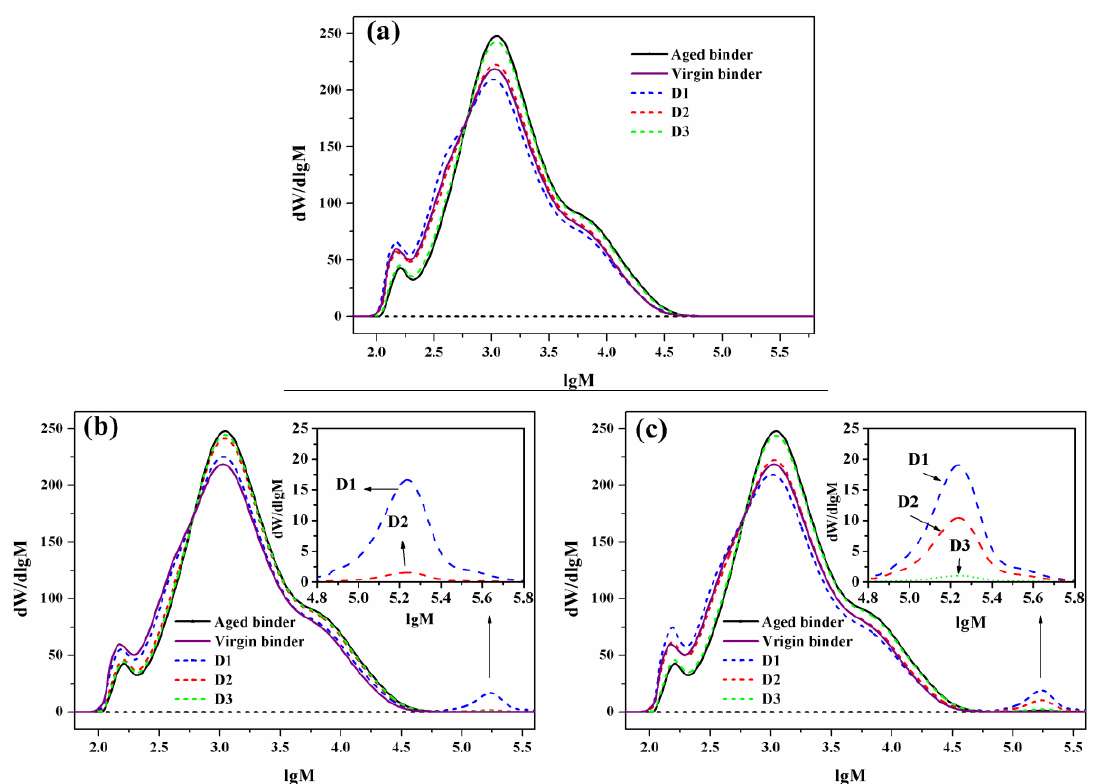
Figure 4. The molecular weight distribution curves for asphalt binder samples: ( a ) virgin binder, aged binder, CR rejuvenated binder in D1, D2 and D3 slices; ( b ) virgin binder, aged binder, MR-1 rejuvenated binder in D1, D2 and D3 slices; ( c ) virgin binder, aged binder, MR-2 rejuvenated binder in D1, D2 and D3 slices.